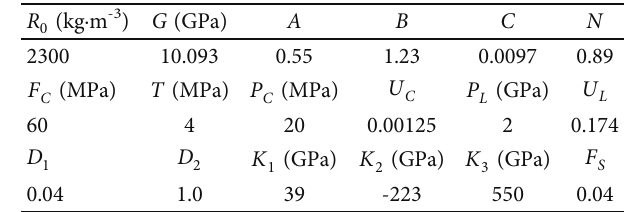
Table 4: Limestone HJC model